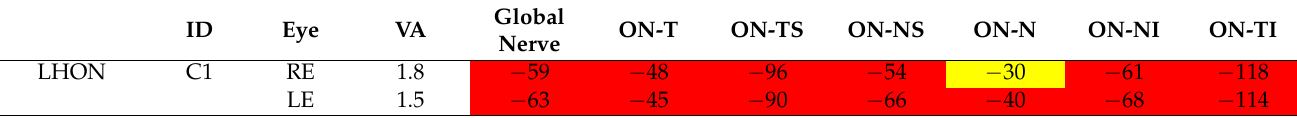
Figure 1. Optic nerve head photo of the left eye with corresponding optic nerve head retinal nerve fibre layer (RNFL) thickness measurement in different study subjects, C6 chronic LHON showing established optic nerve pallor ( A ), U15 asymptomatic carrier with unilateral optic nerve RNFL thinning and temporal pallor ( B ), and U5 asymptomatic carrier with normal optic nerve findings ( C ). Of those asymptomatic relatives with reduced optic nerve head RNFL (5 eyes of 4 asymptomatic carriers), one had normal visual acuity, and the remaining three had unilateral reduced visual acuity, on the same side as the thinning in RNFL, see Table 3. Table 3. Deviation of optic nerve head retinal nerve fibre layer (RNFL) thickness, with corresponding visual acuity, in LHON and asymptomatic carrier relatives. Visual acuity (VA) is displayed in LogMAR for right eye (RE) and left eye (LE). The RNFL thickness is given in microns, with highlight colour indicating normal thickness (green), above normal (white), borderline thinning (yellow), and thinning (red). The optic nerve segments included are temporal optic nerve (ON-T), temporal superior (ON-TS), nasal superior (ON-NS), nasal (ON-N), nasal inferior (NI) and temporal inferior (TI). C6 left eye is excluded from table as OCT was not available.